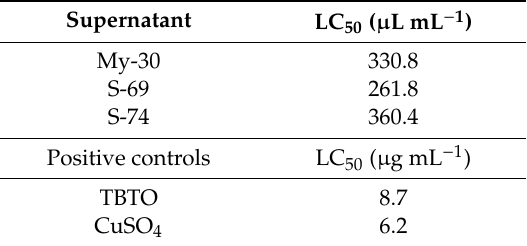
Table 3. Determination of LC 50 values for bacterial supernatants and positive controls (TBTO and CuSO 4 ) on brine shrimp Artemia franciscana nauplii.